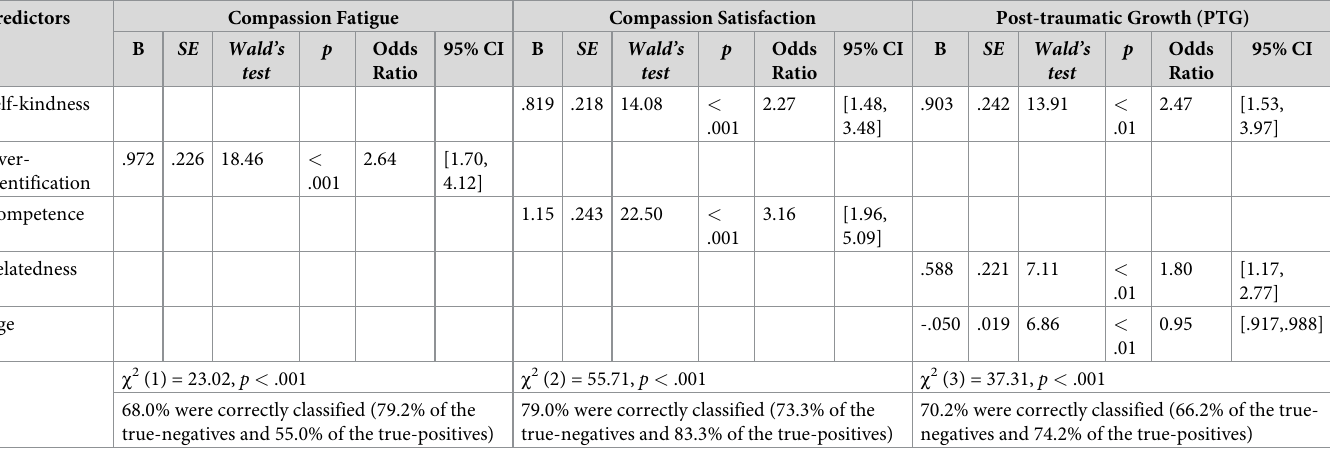
Table 5. Binary logistic regression to predict the highest and lowest levels of the analyzed